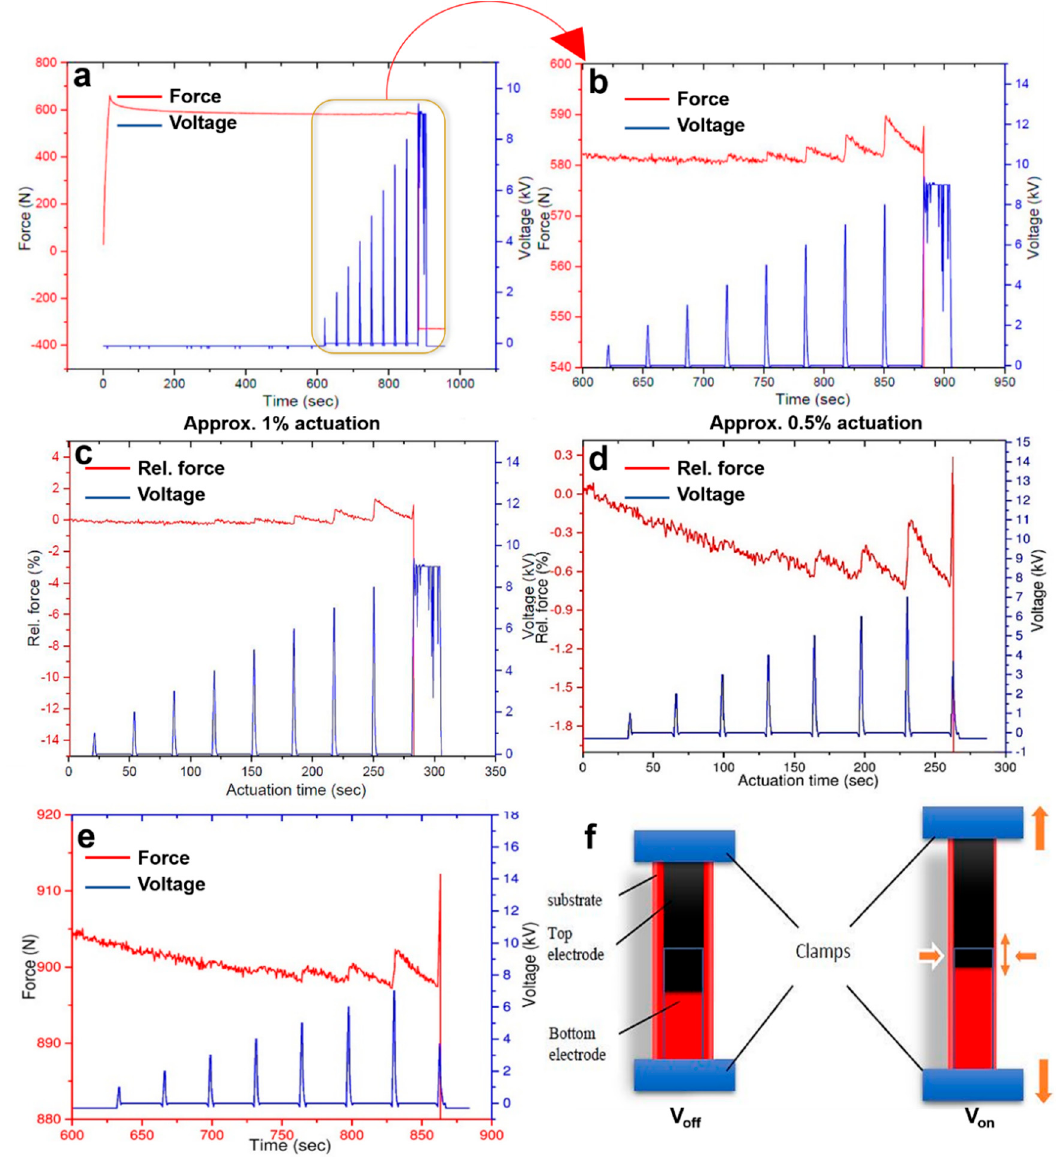
Figure 2. ( a , b ) Actuation profile of NBR 1846 F at 30% prestrain; ( c ) Actuation in terms of relative force (NBR with 30% prestrain) ( d , e ) Actuation profile of NBR 1846 F at 50% prestrain in terms of relative force (abbreviated as Rel. force, %) and force (N), respectively; ( f ) schematic illustration of actuation in voltage off and voltage on condition